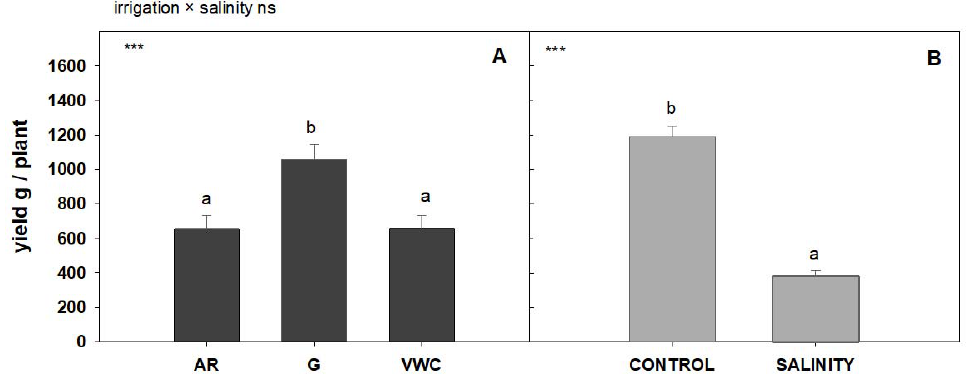
Figure 5. Average sum of commercial weights (gr/Plant) according to water quality and the irrigation method used. The error bar indicates the standard error of the mean (( A ) n = 48 and ( B ) n = 72). Top left in this Figure means: “ns” indicates non-significant differences, and *** significant differences at p < 0.001. Values with different letters are significantly different at 95%, according to Duncan’s multiple range test.